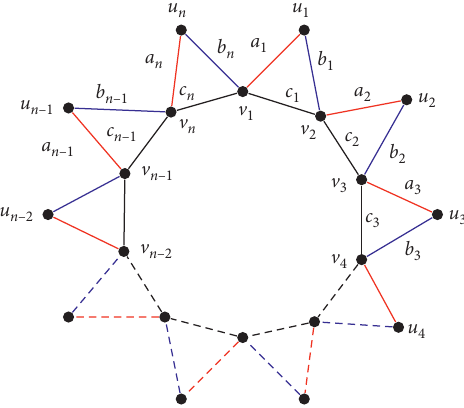
Figure 24: The graph sf